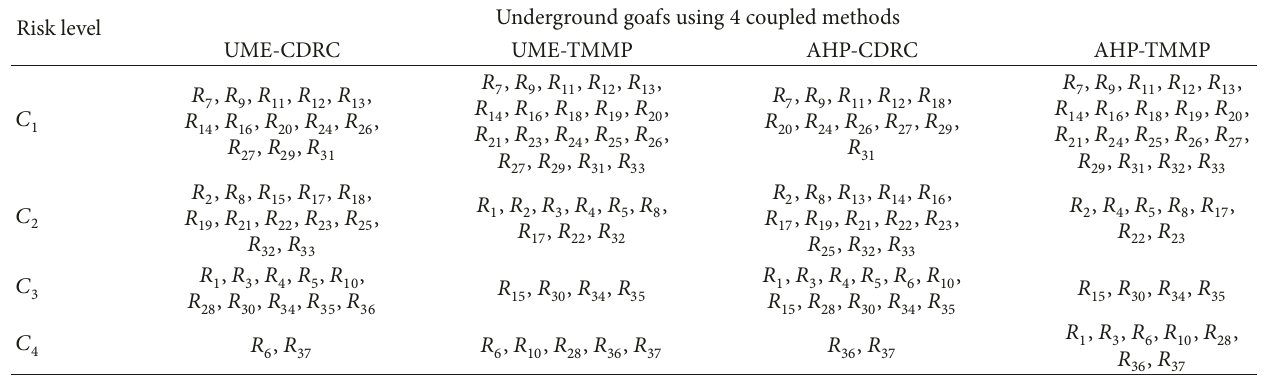
Table 8: The underground goafs of four risk levels with 4 coupled methods.